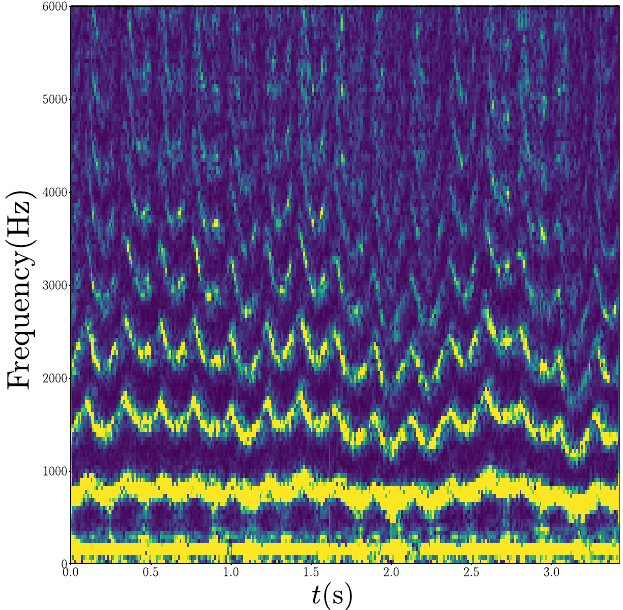
Fig. 3. Spectrogram of a typical audio record of 3 seconds. Experimental conditions are identical to Figure 2. Frequency components are plotted as a function of time. The ladder of intensity goes from dark blue (no frequency component) to yellow (important frequency component). The amplitude modu- lation is represented by the alternation of bright (yellow) and dark zones. Oscillations of the harmonics of the main fre- quency ( ∼ 800 Hz) with the same periodicity as the amplitude modulation are also